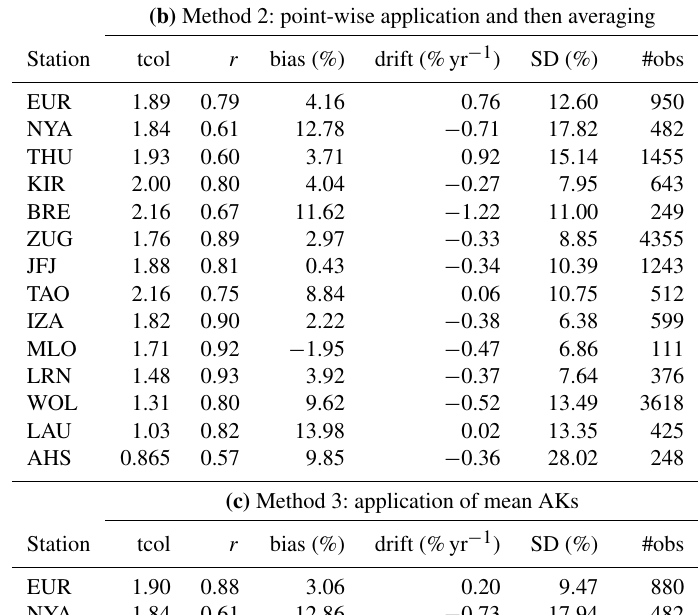
(c) Method 3: application of mean